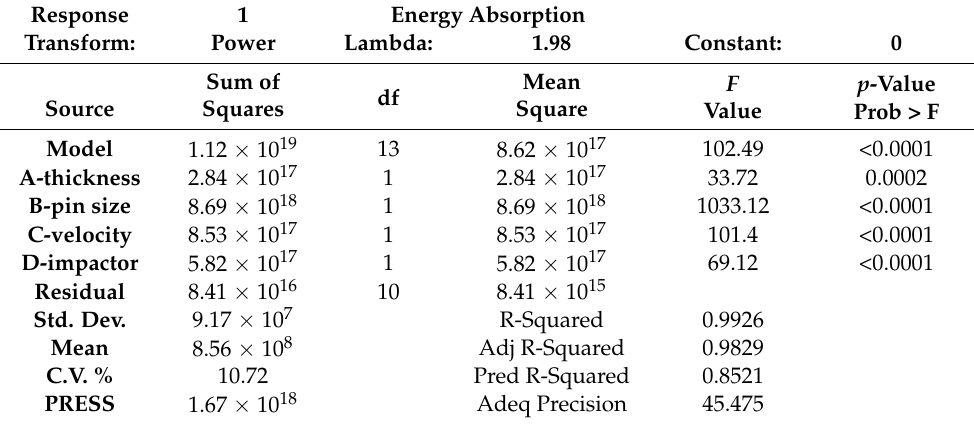
Table 3. ANOVA analysis for Energy absorption as the first response of DOE method.